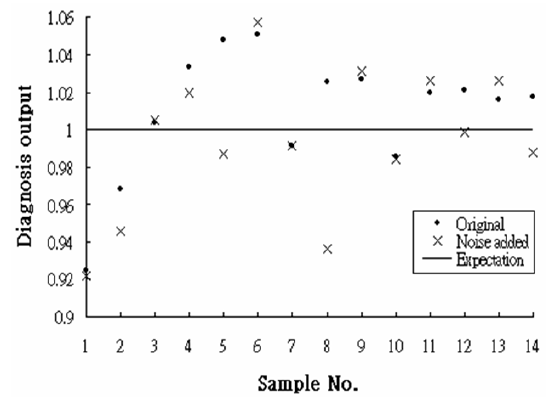
Figure 7. The output of detection for robustness test.